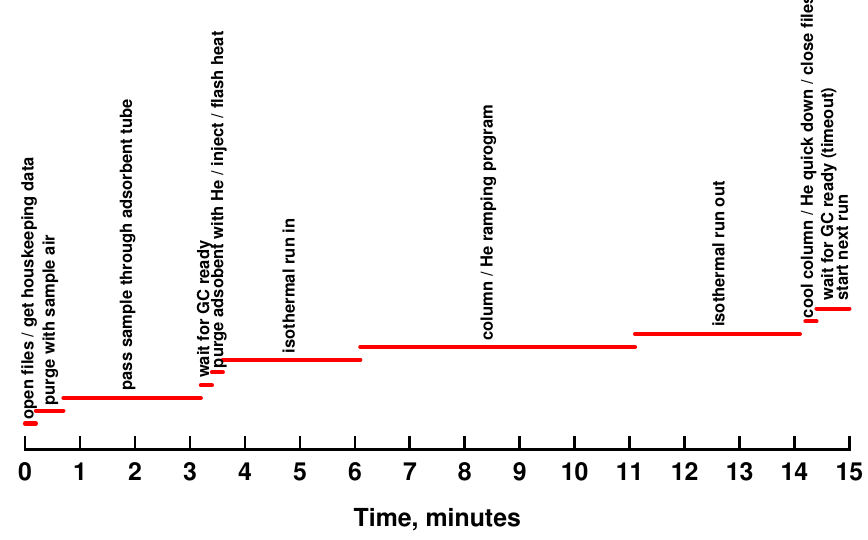
Fig. 2. The various stages of the GC method for a typical µ Dirac chromatogram, shown here with a 15min overall cycle time. Table 2. Typical desorption efficiency and chromatographic performance for µ Dirac target compounds. Compound Formula